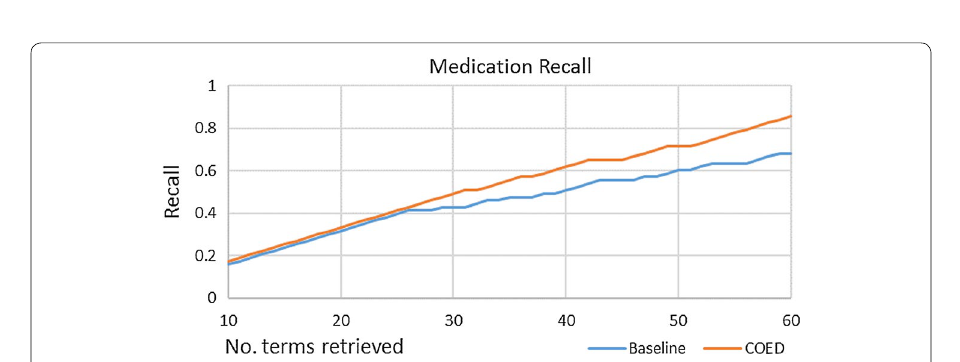
Fig. 13 Comparison of medication recall for baseline and COED methodologies